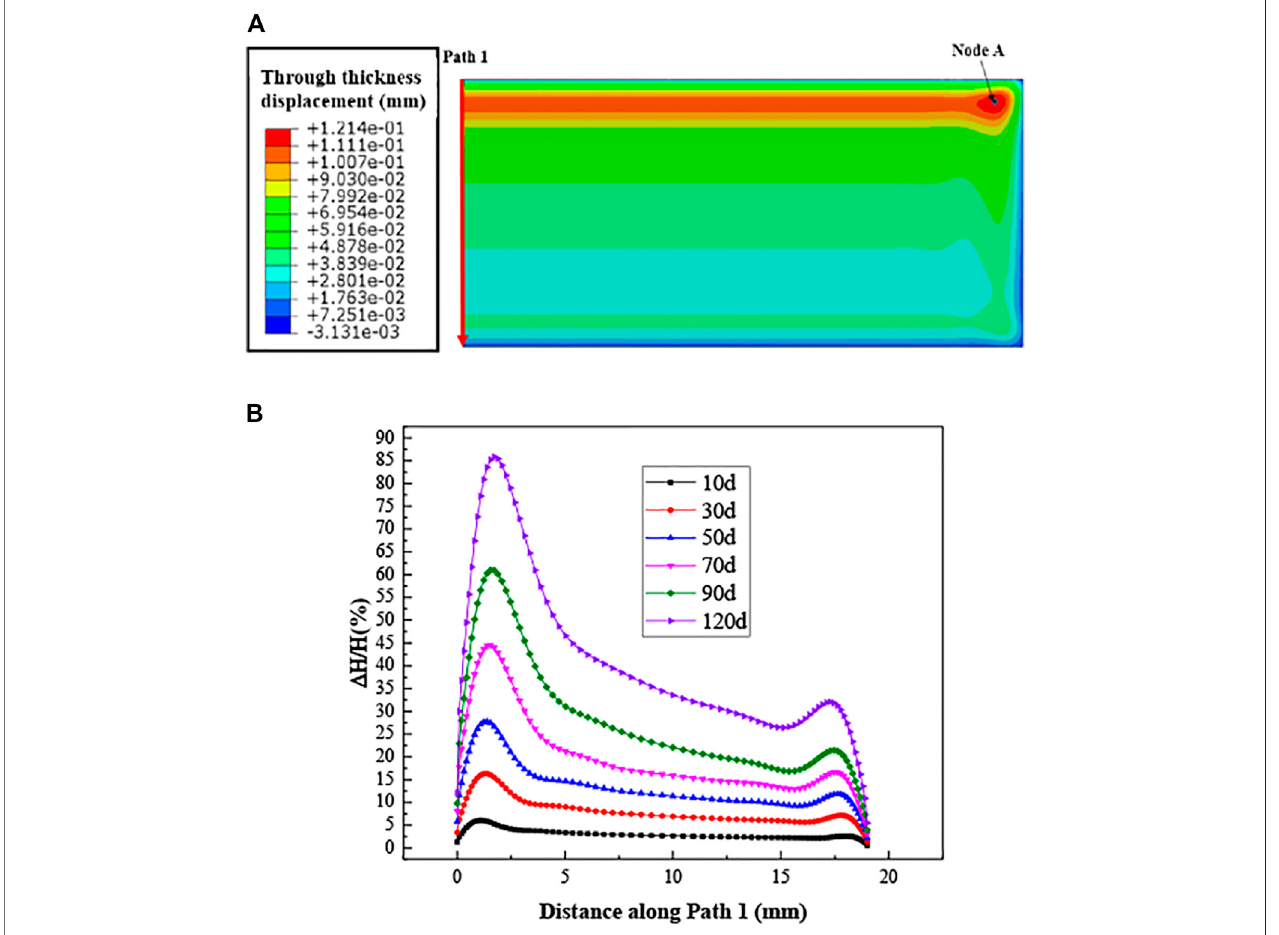
FIGURE 7 | (A) The distribution of the thickness displacement of the fuel meat after the 120 days irradiation; (B) the evolution of the thickness along Path 1.